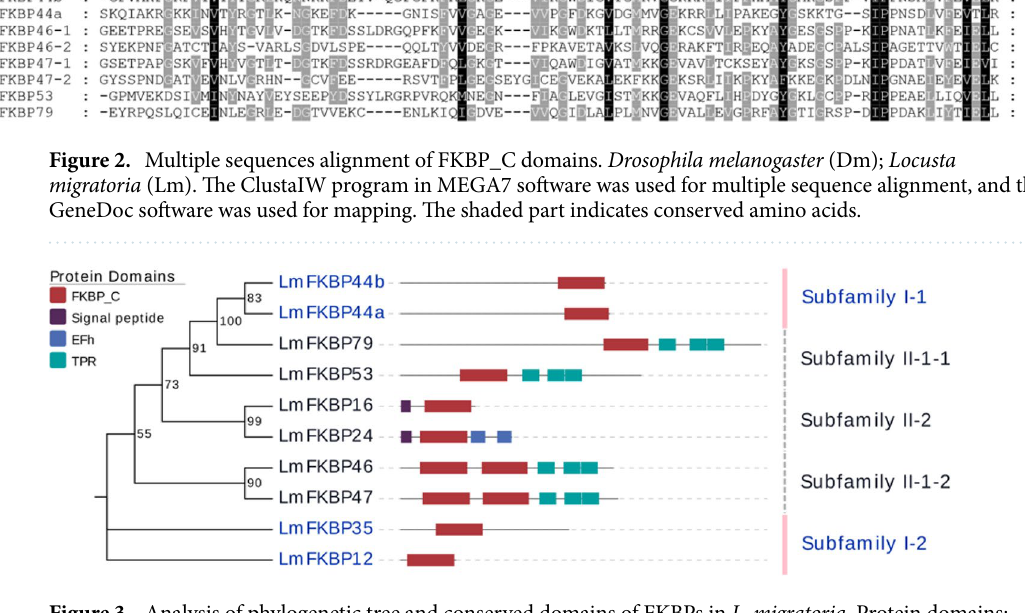
Figure 3. Analysis of phylogenetic tree and conserved domains of FKBPs in L. migratoria . Protein domains: FKBP_C (FKBP-type peptidyl-prolyl cis–trans isomerase), EFh (EF-Hand), TPR (Tetratricopeptide repeats). The EvolView was used to map the phylogenetic tree and the structural domain groups